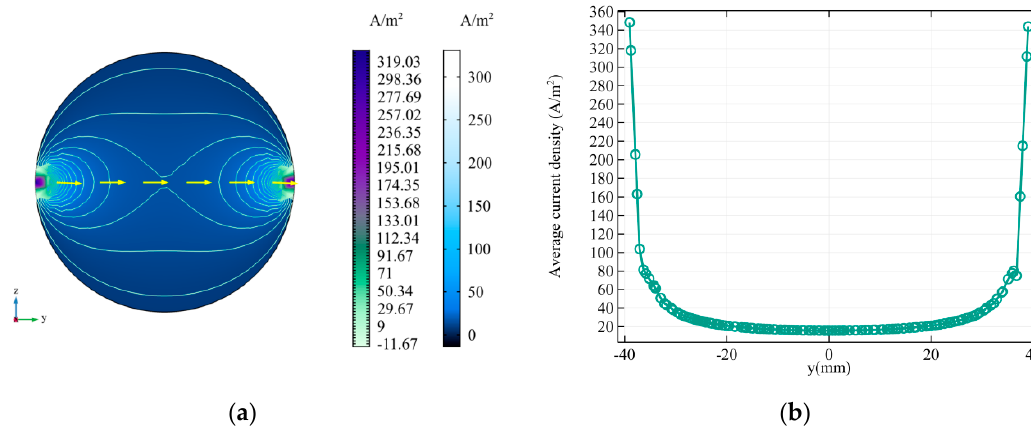
Figure 4. The reciprocal current density distribution on the cross-section. ( a ) y–z views; ( b ) The current density distribution on the connection line of the two electrodes (z = 0).